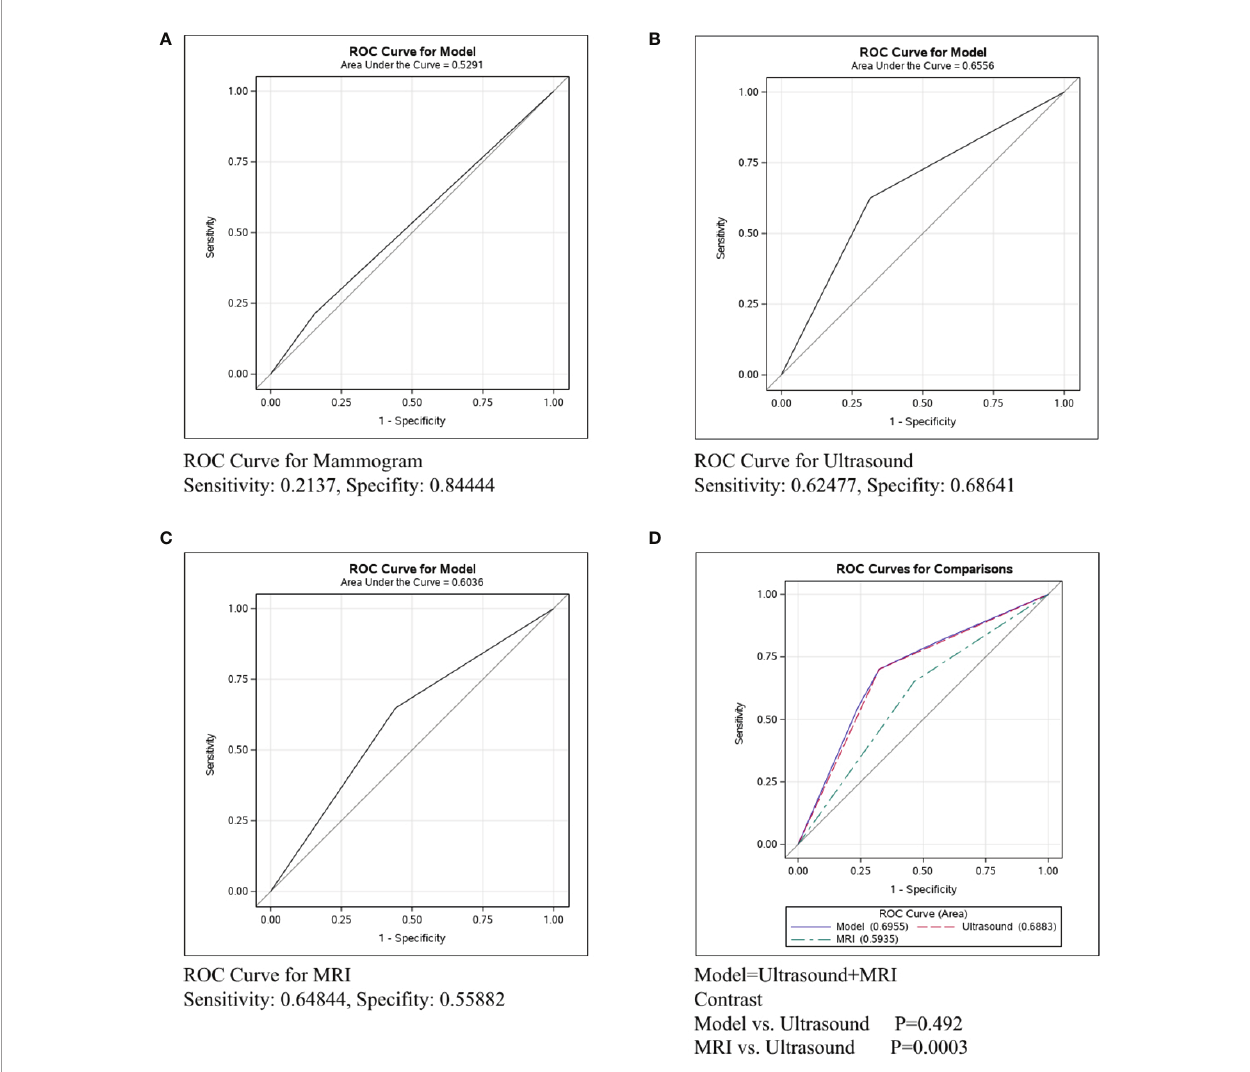
FIGURE 2 | ROC curve analysis for speci fi c imaging examination in Her2+ subtype. The vertical axis is sensitivity, the horizontal axis is 1-speci fi city. AUC is a parameter used to measure the value of imaging examination in the prediction of axillary lymph nodes. (A) ROC curve for mammogram. (B) ROC curve for ultrasound. (C) ROC curve for MRI. (D) ROC curve for